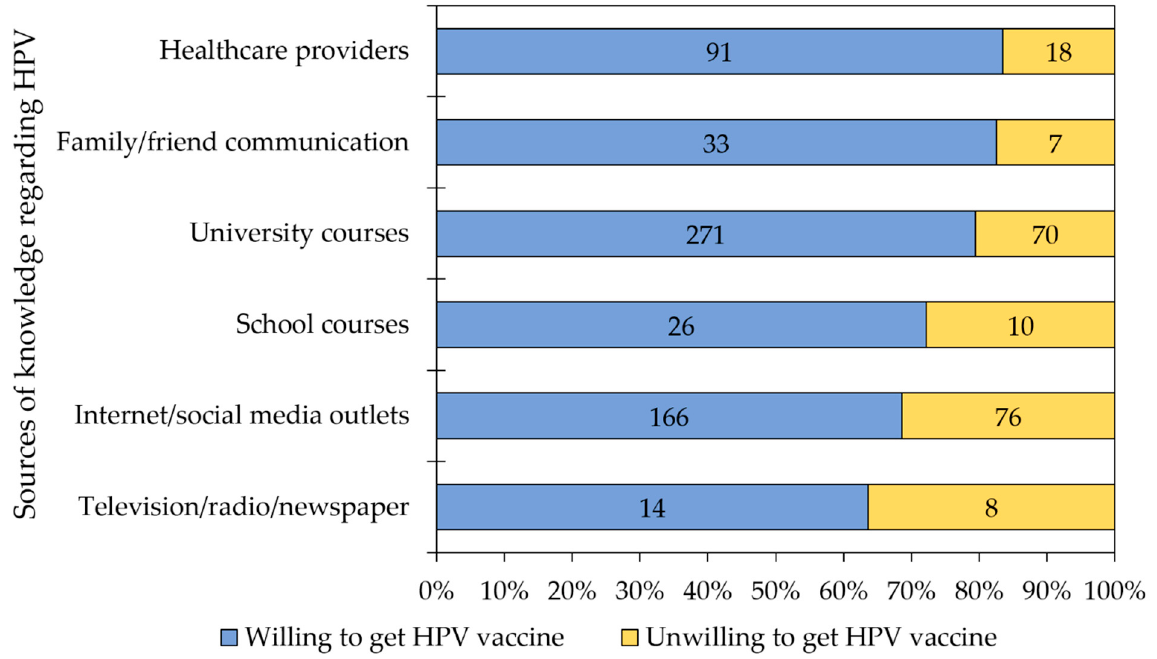
Figure 4. The sources of knowledge regarding the human papillomavirus virus among the study participants who had heard of the virus prior to the study. Multiple selections were allowed for each participant.